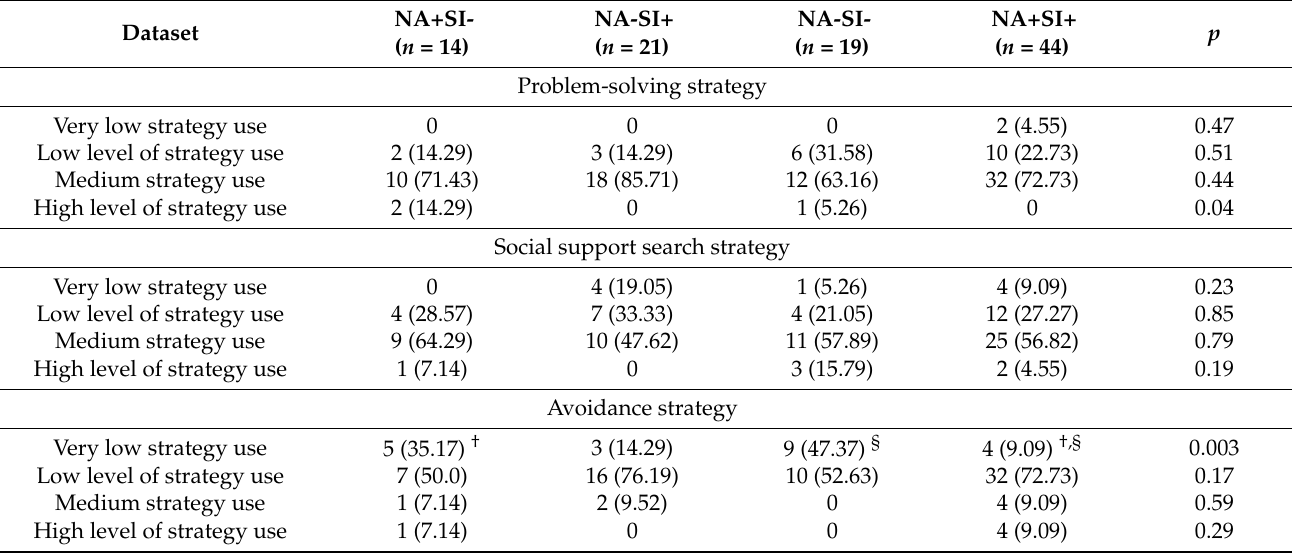
Table 3. Coping Strategy Indicator (CSI),